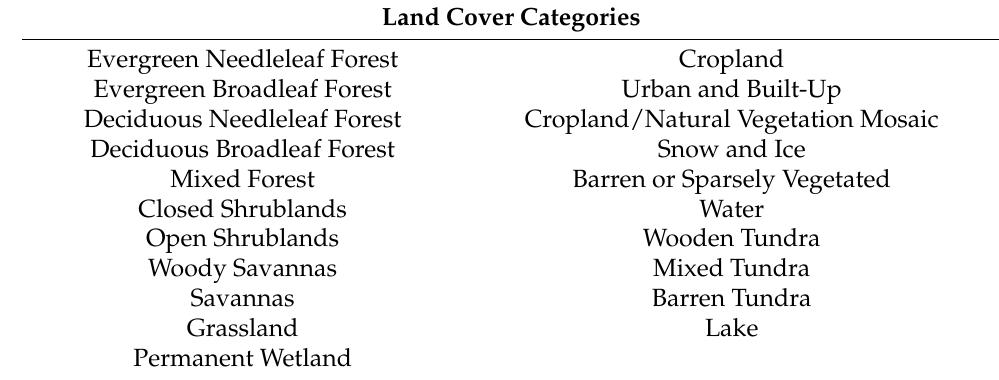
Table 1. IGBP-MODIS classification